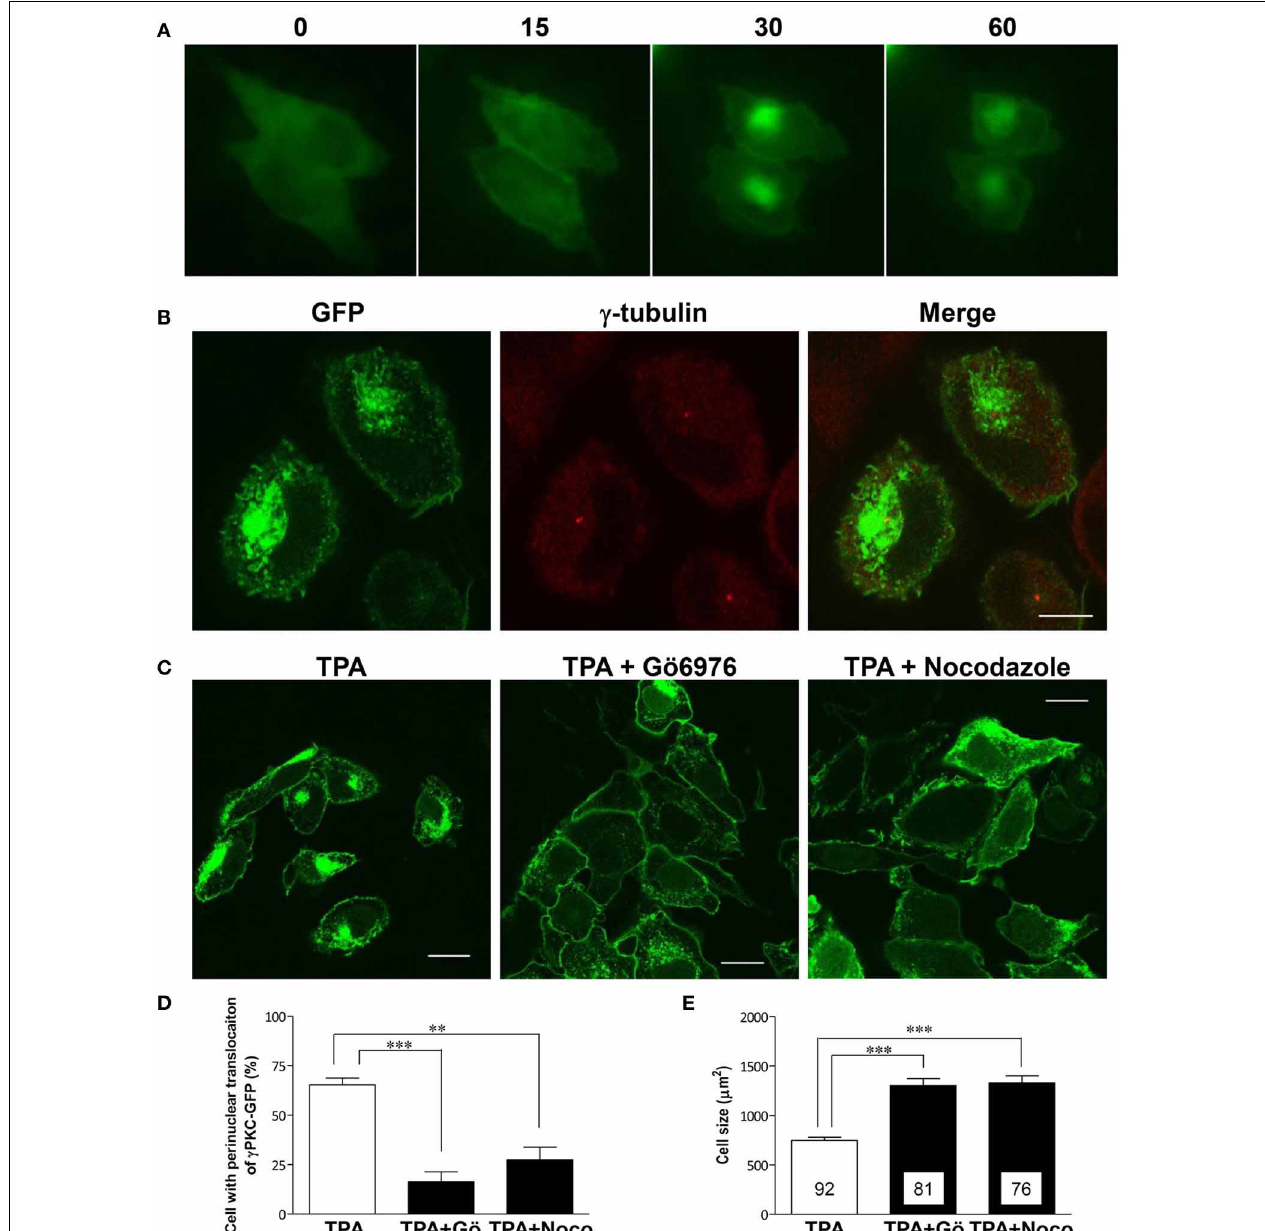
FIGURE 1 | γ PKC is translocated around the centrosome in microtubule- and PKC kinase activity-dependent manners. (A) Time-lapse imaging of γ PKC-GFP expressing HeLa cells treated with TPA. γ PKC-GFP expressing cells were treated with 100nM TPA for 1h. These images were obtained from the same cells at each time point (0, 15, 30, and 60min) after TPA treatment. The translocations of γ PKC-GFP to the plasma membrane (15min) and to the perinuclear region (30 and 60min) were observed, accompanied by a reduction in cell size (30 and 60min). Bar = 10 μ m. (B) γ PKC translocation around the centrosome. Representative fluorescence images ( γ PKC-GFP, γ -tubulin, and merged) of γ PKC-GFP-expressing HeLa cells treated with 100nM TPA for 60min, followed by immunostaining with an anti- γ -tubulin antibody, a marker of the centrosome. Translocated γ PKC-GFP was localized around the centrosome. Bar = 10 μ m. (C–E) γ PKC translocation around the centrosome and cell shrinkage were dependent on microtubules